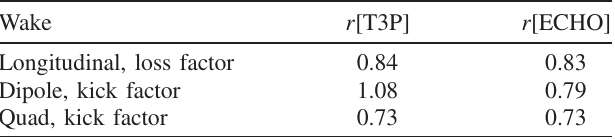
TABLE I. For the Pohang dechirper, for a Gaussian bunch with σ ¼ 0 . 5 mm: the ratio of the numerically obtained and the z analytical result (see [25]), that we denote by r . We compare the results given in Ref. [26], r [T3P], with the new results, r [ECHO]. Wake r [T3P] r